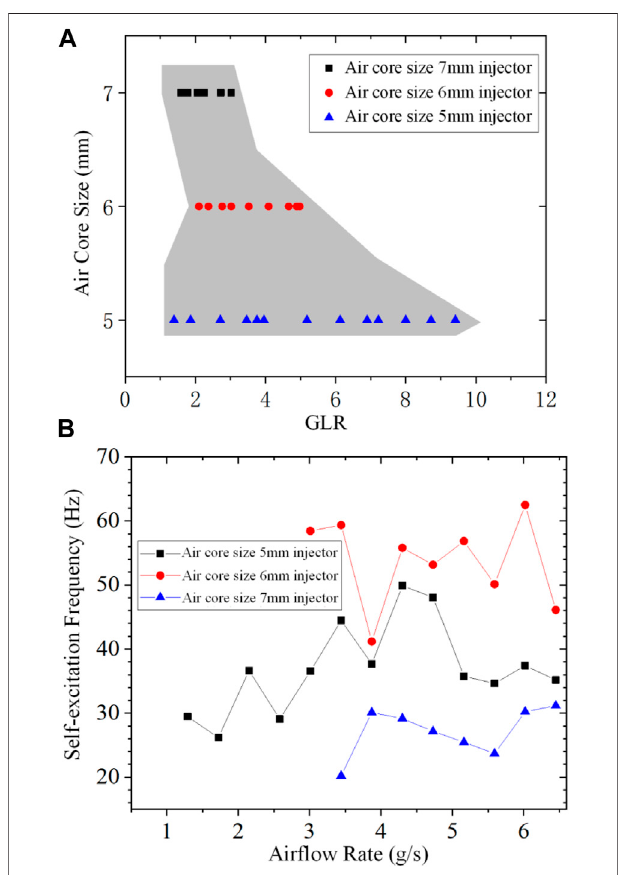
FIGURE 15 | Impacts of the gaseous core size on (A) the activation of self-oscillation phenomena under the different gas – liquid momentum ratios under the different gaseous fl ow rates and (B) the self-oscillation frequency under the different gaseous fl ow